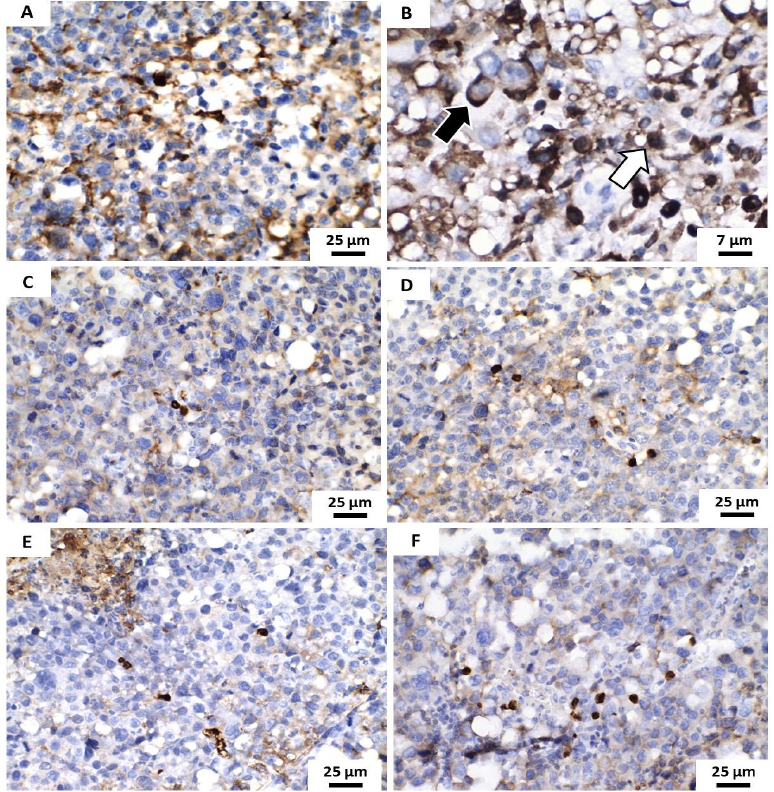
Figure 9. Photomicrographs of histological sections demonstrate the immunohistochemical expression of the Ki67 antigen (brownish color) in the analyzed tumors. ( A , B ) Vehicle Group shows tumor cells showed predominantly nuclear positivity (light arrow) and eventually, cytoplasmic immunoexpression of this antigen (dark arrow). ( C – F ) represent the groups treated with 5-FU (25 mg/Kg/day) and 50, 100 and 200 mg/Kg/day of the formulation contain POH/ β -CD inclusion complex.